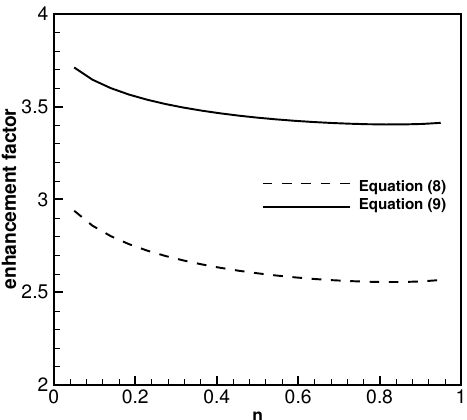
Figure 4. Current enhancement coefficients corresponding to the small α value (represented by the solid and black line in Figure